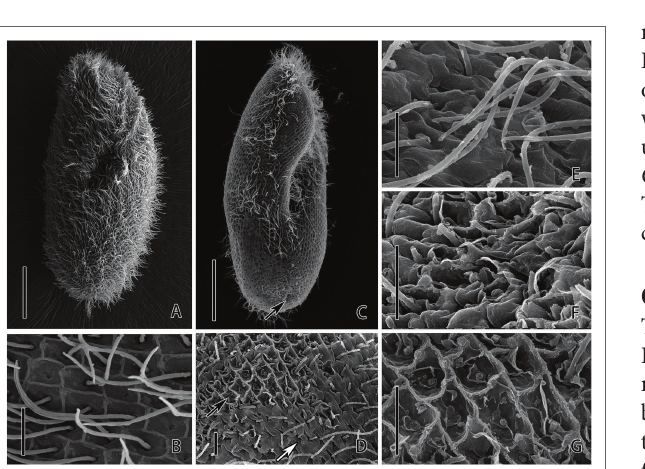
Supplementary Figure S1 . Raw sequence data associated with this project has been deposited at sequence read archive (SRA) with the SRA accession number SRR17555526 to SRR17555531 and the BioProject accession identity PRJNA795022.